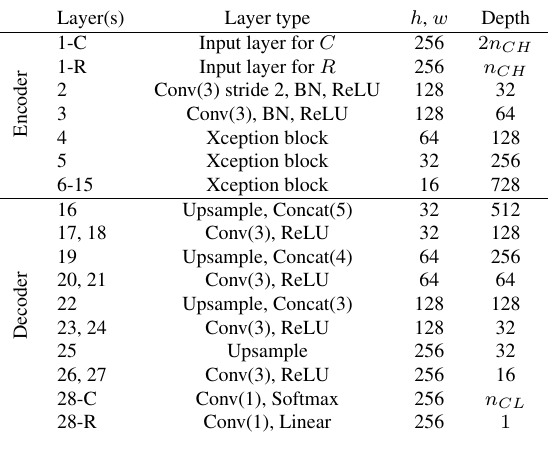
Table 1. Layers of the architectures of C and R . Both models are based on the same architecture, but have different input and output layers. Conv( s ): convolution with kernel size s × s ; BN: Batch-Normalization; ReLU: rectified linear unit. Concat(X) : depth-wise concatenation of the output of layer X and the current layer. Depth, h , w : output